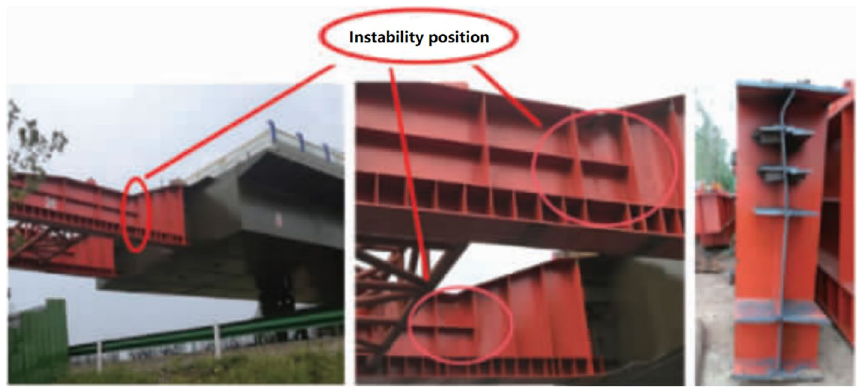
Fig. 23 Instability diagram of guide